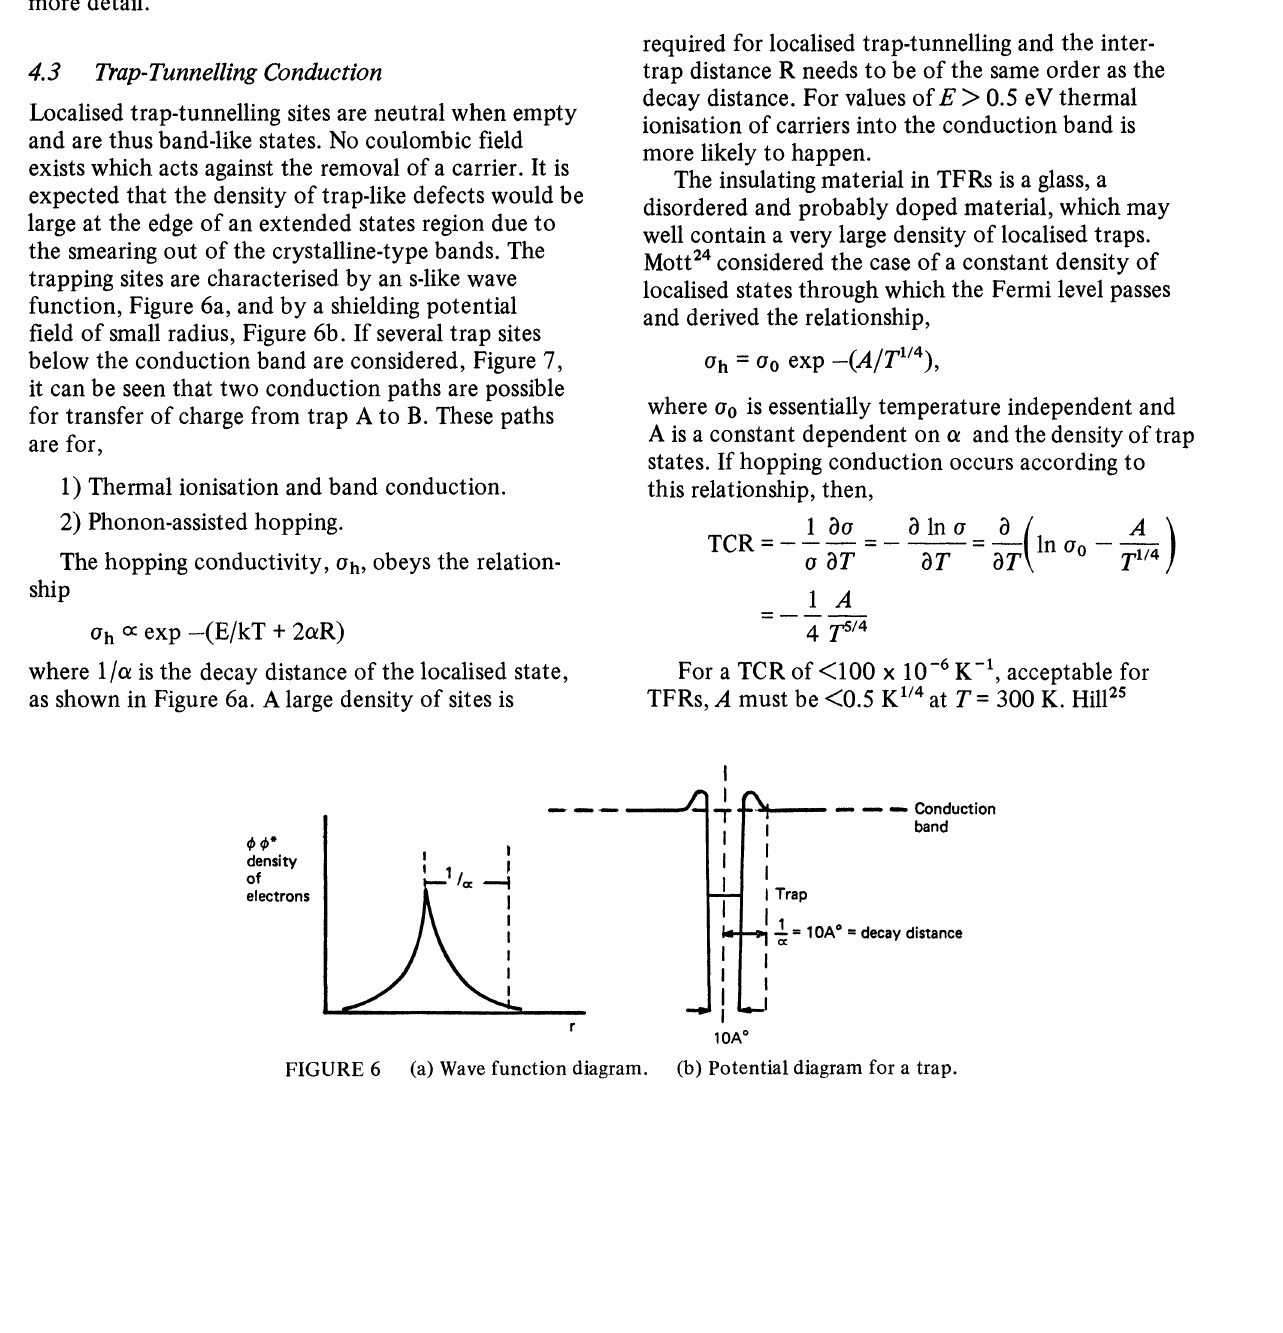
Charge transfer via traps.